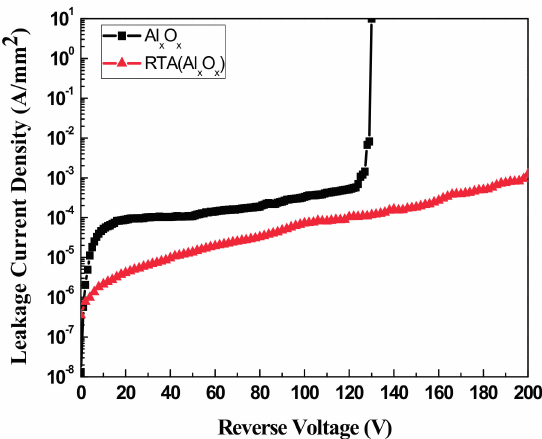
Figure 10. The breakdown voltage of the SBDs with guard ring structure raised to 130 V before the RTA annealing process and further increased to over 200 V after the RTA annealing.